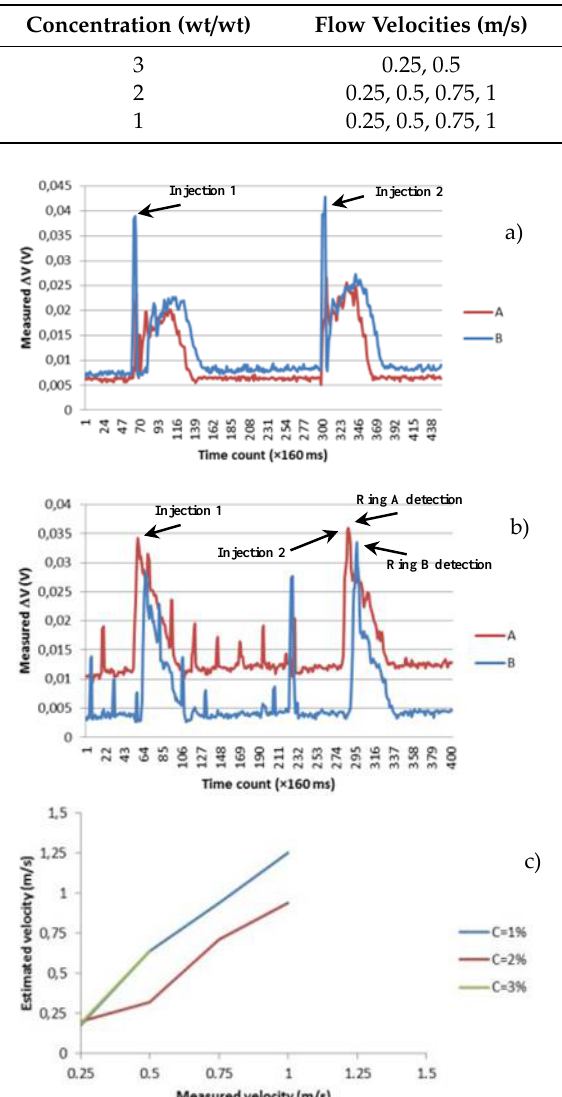
Table 2. Table of fibre concentrations and flow velocities used for the velocity estimation tests .